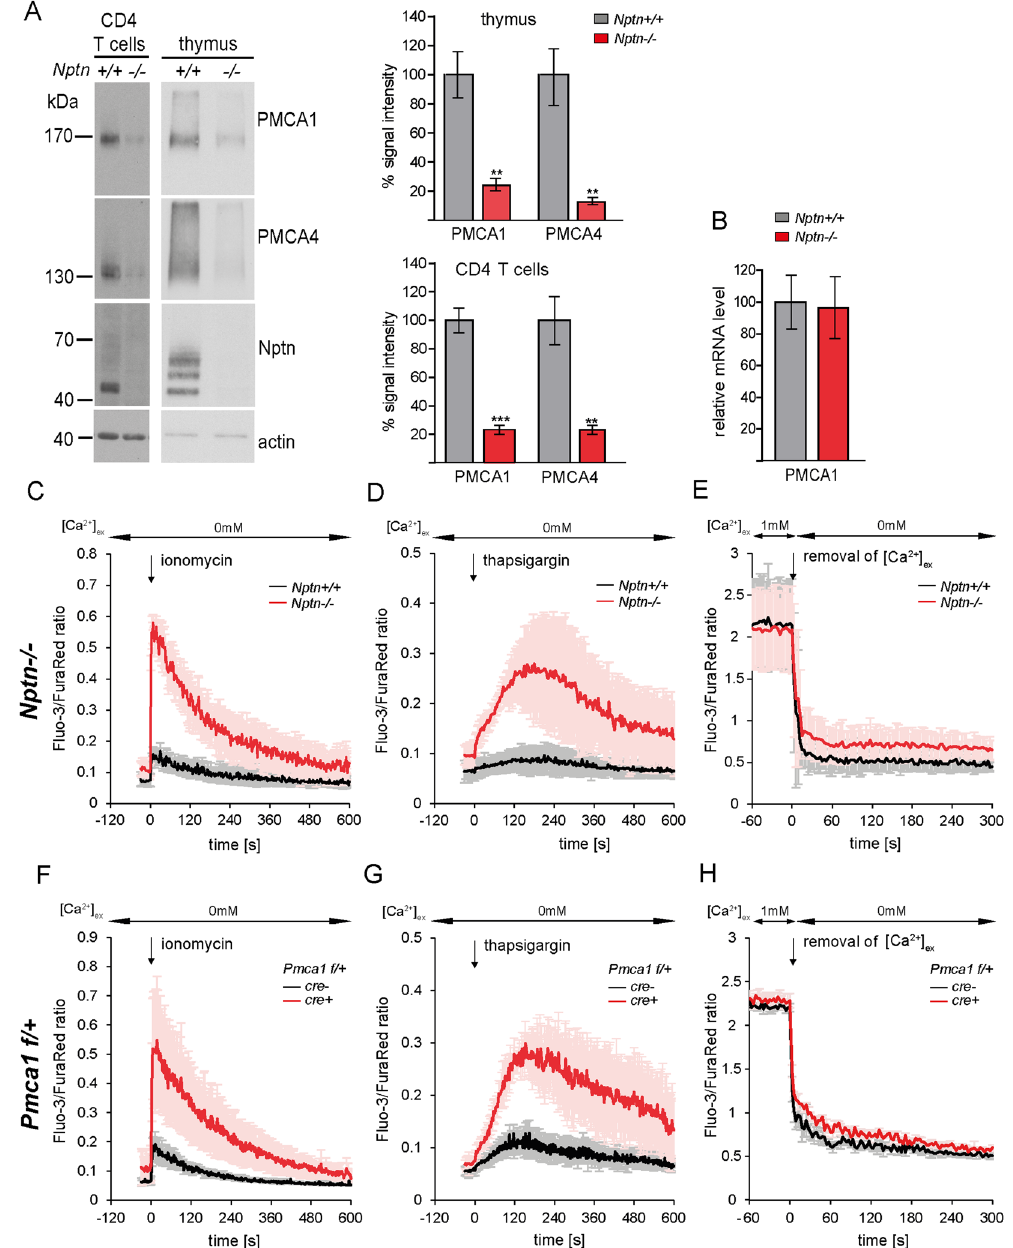
Figure 5. Neuroplastin is required for PMCA stabilization and Ca 2 + clearance. ( A ) Western blot analysis of PMCA1, PMCA4 and Neuroplastin in wt and Nptn − / − samples from CD4 T cells and thymus. Representative blots show lack of Neuroplastin and strong reduction of PMCA1 and PMCA4 in Nptn − / − CD4 T cells and thymus. Signal intensities were quantified by densitometry using β -actin signals for normalization. Bar graphs show mean ± SEM from 4 wt and 4 Nptn − / − replicate thymus samples, and from 3 samples of CD4 T cell extracts each, ** p < 0.01, *** p < 0.001, unpaired two-tailed t-test. ( B ) qRT-PCR of PMCA1 transcript levels in lymph node cells. B2m and Hprt served as references for normalization. Graph shows mean relative transcript levels ± SD derived from 7 samples per group. ( C – E ) Flow cytometric ratiometric measurement of post-stimulatory Ca 2 + clearance in wt or Nptn − / − naïve CD4 T cells. After baseline recording, Ca 2 + release from internal stores was induced in Ca 2 + -free buffer by 1 μ g/ml ionomycin. Kinetics of the mean Fluo-3/FuraRed ratio ± SD from 3 experiments is shown ( C ). Ca 2 + release from the ER was induced by 1 μ g/ml thapsigargin in Ca 2 + -free buffer. Mean ratios ± SD from 4 experiments are shown ( D ). Ca 2 + clearance across the plasma membrane, investigated after thapsigargin treatment as in ( D ) and consecutive induction of SOCE by resuspending cells in buffer containing 1 mM Ca 2 + . High Fluo-3/FuraRed ratios were recorded for 1 min before Ca 2 + clearance was induced by resuspending cells in Ca 2 + -free buffer again, and recording was immediately continued. Mean ratios ± SD from 5 experiments are shown ( E ). ( F , G ) Ca 2 + levels in Pmca1